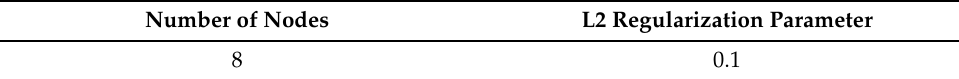
Table 4. Error NN model Hyperparameters found through grid search for homogeneous reser- voir case.